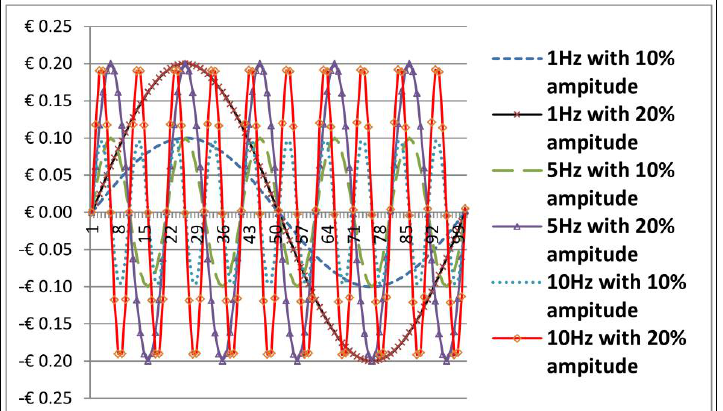
Figure 6. Six sets of sine wave as frequencies in Hz of 1, 5 and 10 with the amplitude of 10% and 20% of exchange